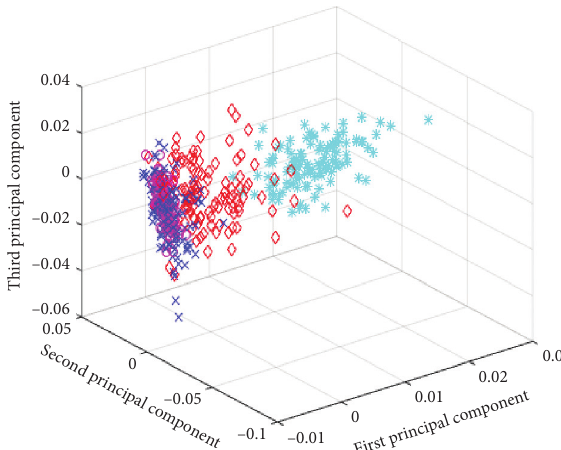
Figure 27: Recognition result of test signal based on LE.